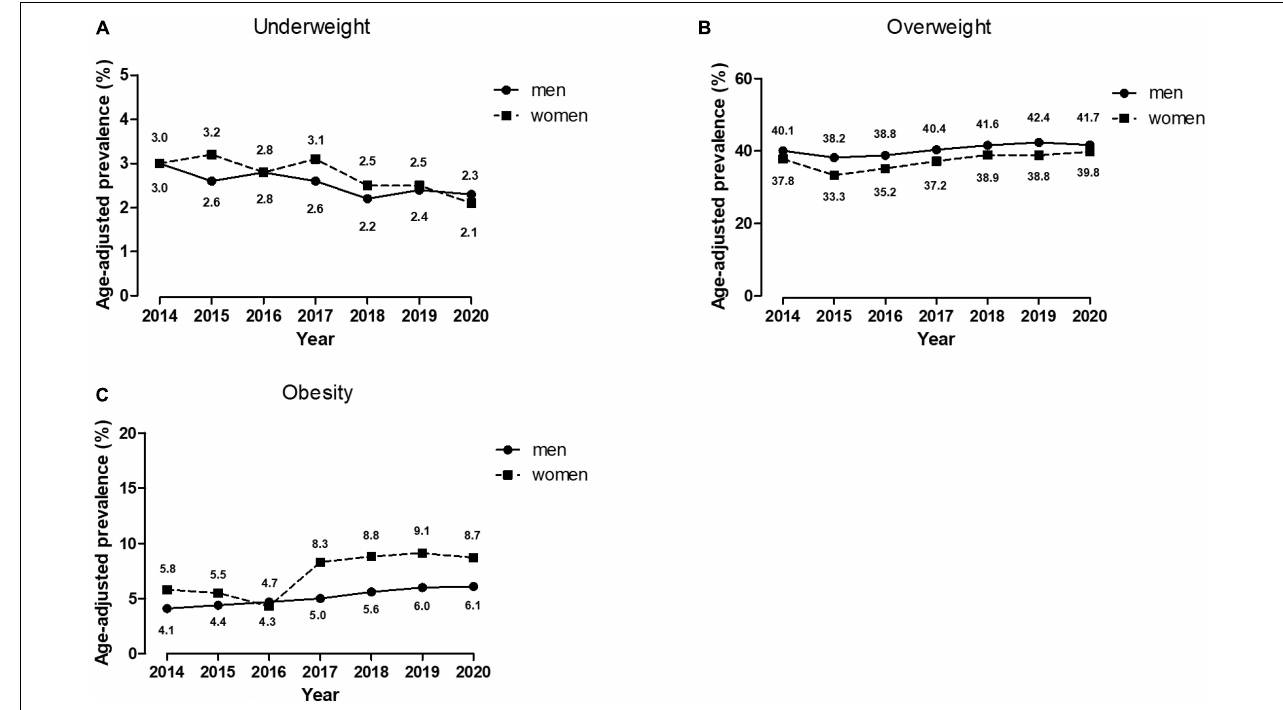
FIGURE 1 | Age-standardized prevalence of underweight, overweight and obesity in 50,192 Chinese aged participants from 2014 to 2020. The estimated prevalence was age-standardized to the 2020 census of the Shanghai Aged population by the direct method. (A) Age-adjusted prevalence of underweight; (B) Age-adjusted prevalence of overweight; (C) Age-adjusted prevalence of